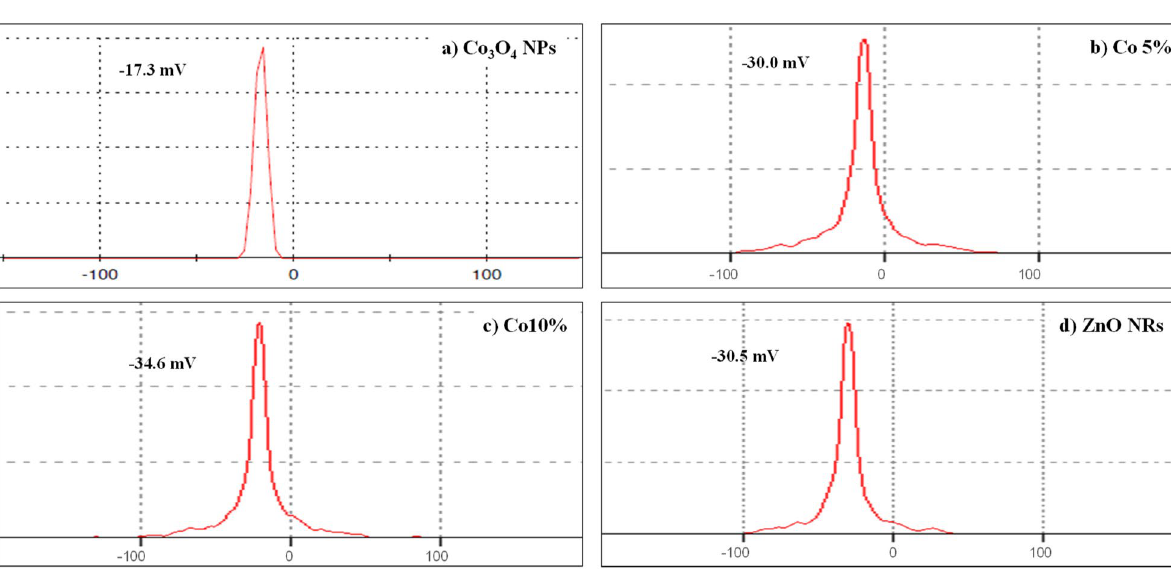
Figure 11. Zeta potential distribution of ( a ) Co 3 O 4 NPs, ( b ) Co 5%, ( c ) Co 10% and ( d ) ZnO